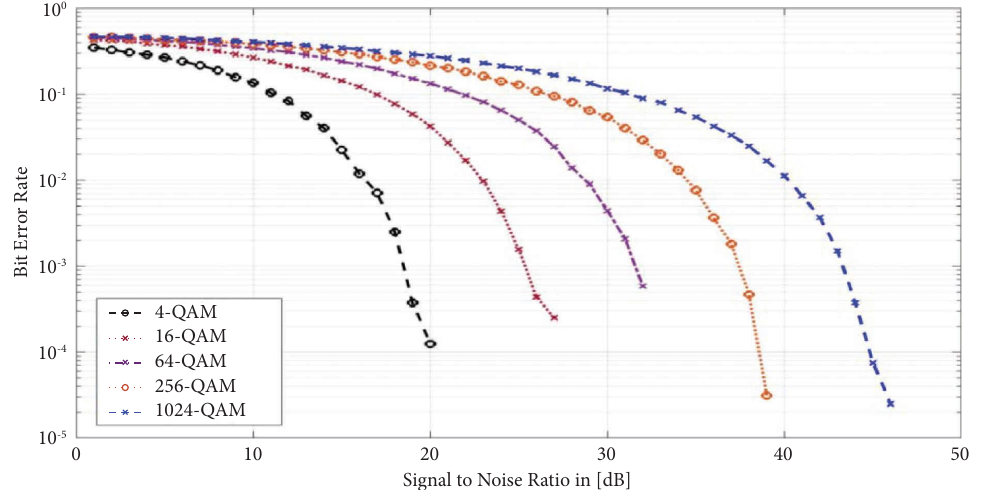
Figure 8: OFDM at diferent QAM